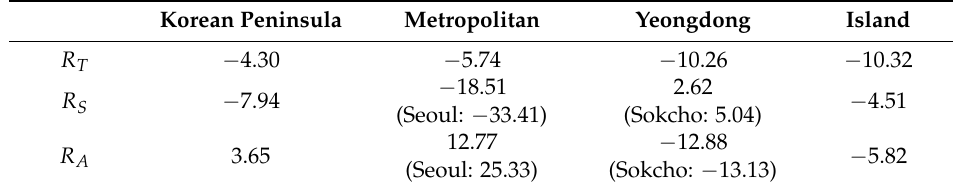
Table 12. Energy budgets for the Korean Peninsula, metropolitan, Yeongdong, and island regions at the top of the atmosphere ( R T ), the surface ( R S ), and the atmosphere ( R A ) (unit: Wm − 2 ). Korean Peninsula Metropolitan Yeongdong Island R T − 4.30 − 5.74 (Seoul: −